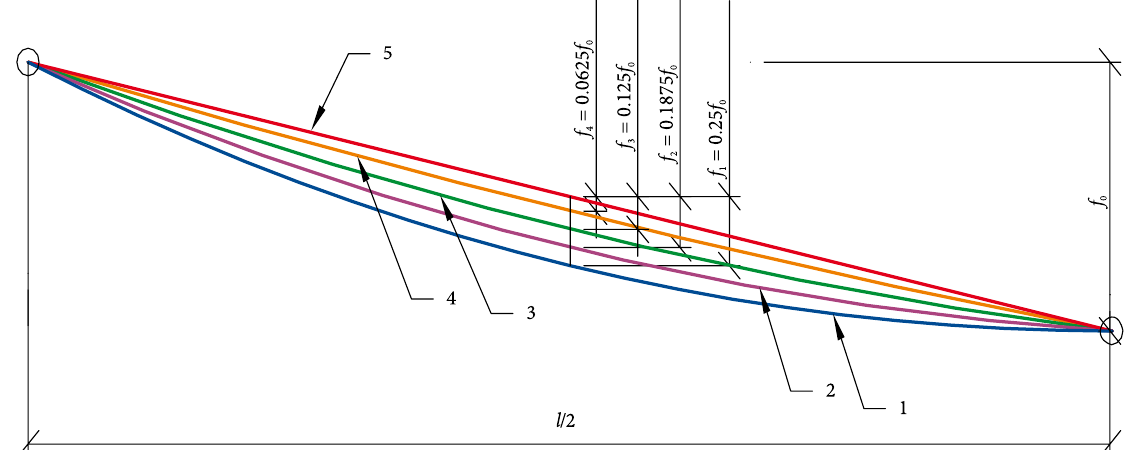
Fig. 12. Geometrical shapes of a rigid cable in a half of bridge span: 1 – f 1 = 0.25 f 0 ; 2 – f 2 = 0.1875 f 0 ; 3 – f 3 = 0.125 f